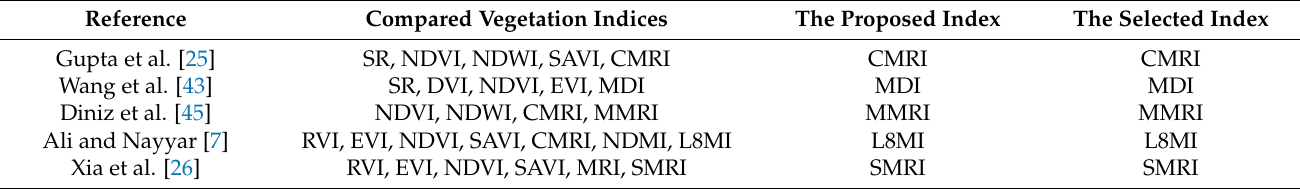
Table 4. A summary of the vegetation indices proposed and compared by various authors to map mangrove forests on Landsat 8